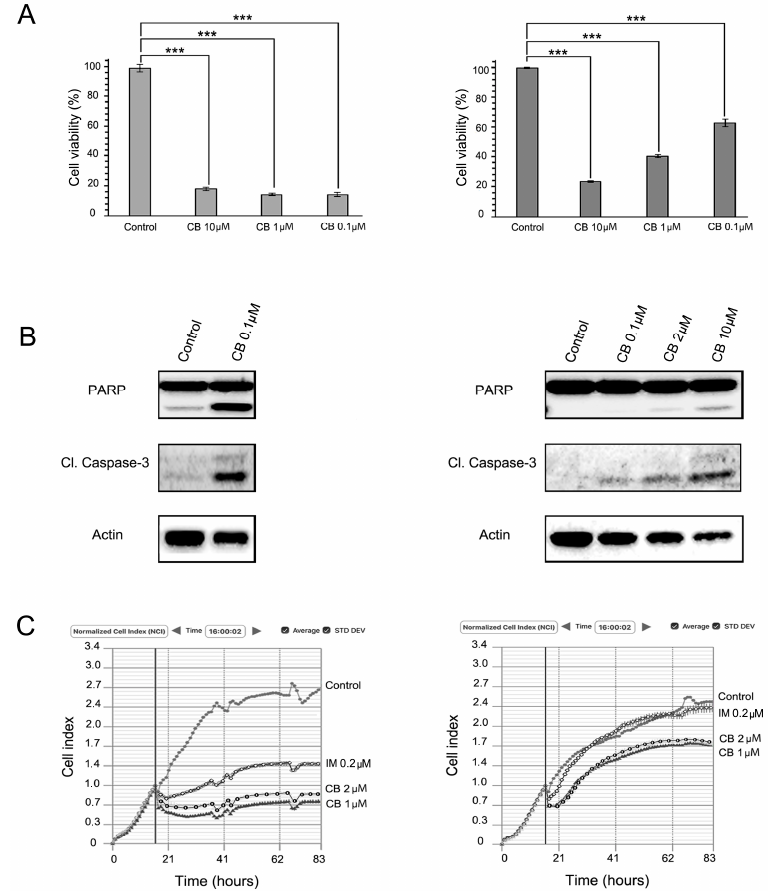
Figure 3. Cabozantinib (CB) inhibits proliferation, growth kinetics and induces apoptosis in IM-sensitive and IM-resistant GIST cells. ( A ) MTS-based viability assay of GIST T-1 and GIST T-1R cells. Treatment with DMSO (control) or CB in GIST T-1 (left) and GIST T-1R (right) cells. Data of triplicates are represented as the mean ± SD. ***: p ≤ 0.001; ( B ) Immunoblot analysis for apoptosis markers (cleaved forms of PARP and caspase-3) in GIST cells after treatment with DMSO (control) or CB for 72 h. Actin stain used as a loading control; ( C ) Changes in growth kinetics of GIST T-1 (left) and GIST T-1R (right) cells treated with DMSO (control), IM (positive control) or CB.